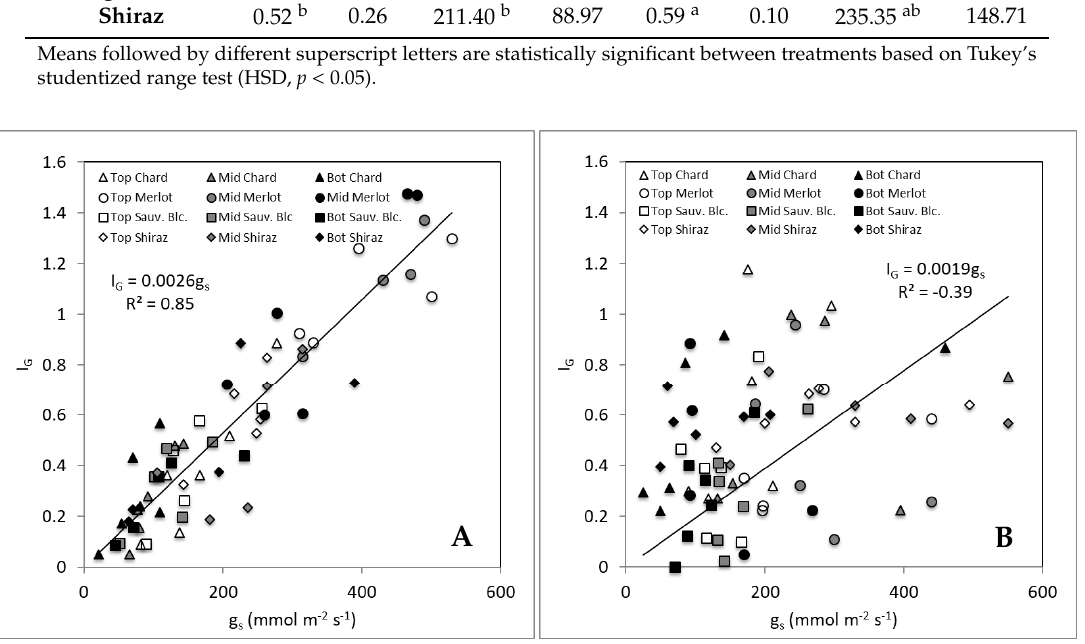
Figure 5. Relationship between g s and I g for Experiment 1 in the four cultivars with data separated between canopy sections: top (Top), middle (Mid) and bottom (Bot) measurements for control treatments ( A ) and smoked treatments ( B ).